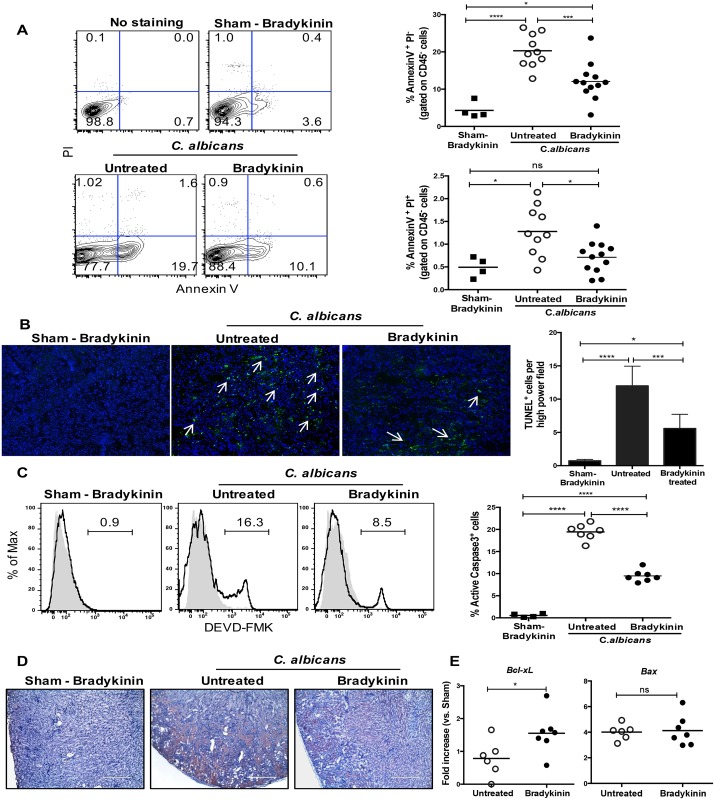
Apoptosis of kidney-resident cells is reduced in bradykinin treated mice in candidiasis.WT mice were treated with bradykinin (300 nmol/kg/day) starting 1 day prior to infection and daily for 7 days. Sham-infected WT mice were treated with bradykinin. (A) At day 7 p.i. (n = 4–12), early and late apoptotic kidney resident cells (gated on CD45- cells) were quantified by AnnexinV and PI staining. (B) Frozen kidney sections (n = 4–8) were subjected to TUNEL staining and counterstained with DAPI. White arrows indicate TUNEL+ cells. The number of TUNEL+ cells was quantified in 15 randomly selected high powered fields (400X). Original magnification: 100X. (C) Frequency of cleaved Caspase-3+ kidney-resident cells (gated on CD45- cells) were quantified by flow cytometry (n = 4–6). Solid histogram: Negative control; Open histogram: DEVD-FMK staining. (D) Serial kidney sections (n = 4–6) were stained for cleaved Caspase-3. (E) Sorted kidney-resident cells (CD45-) (n = 6–7) were evaluated for the expression of Bcl-xL and Bax mRNA by qPCR. Data pooled from 2 and 3 independent experiments for (A-D) and (E), respectively. Each dot represents one mouse and bars indicate mean. Bar indicates mean ± S.D. P <0.05 (*), <0.01 (**), <0.0001 (****). ns, not significant.